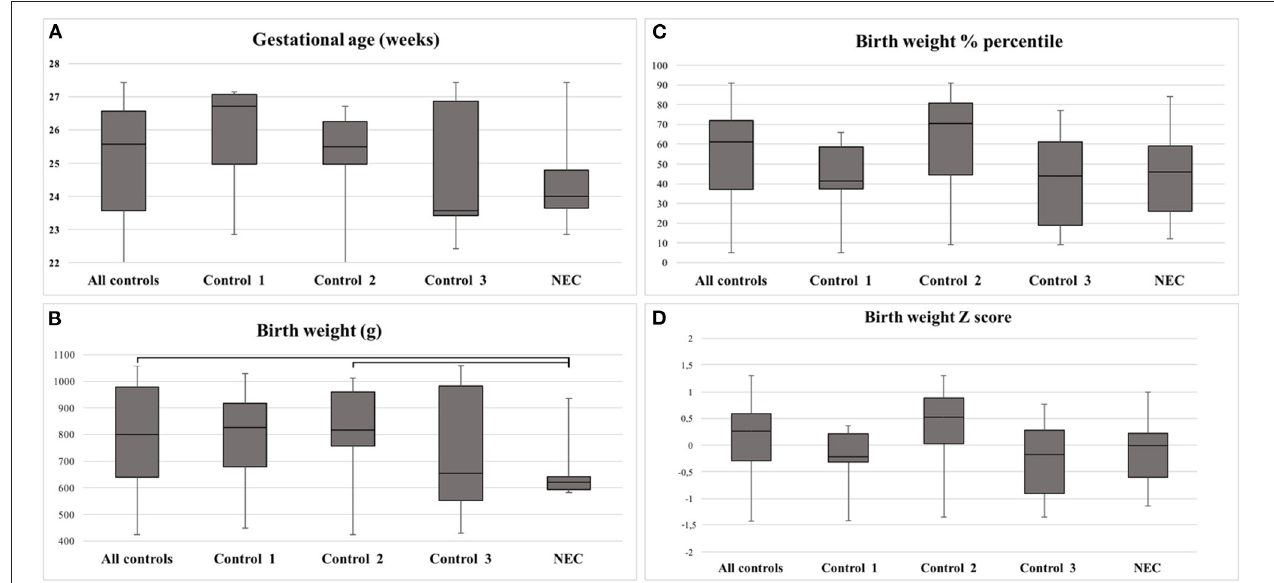
FIGURE 4 | (A–D) Clinical data for the study population and detected differences. (A) Gestational age (GA) in weeks and days. (B) Birth weight (BW) in grams. (C) BW in percentiles. (D) BW in Z score. Note that BW differed between all controls and the necrotizing enterocolitis (NEC) group, as well as between Control 2 and the NEC group. Bars depict significant differences. Statistical calculations displayed in Table 2 .